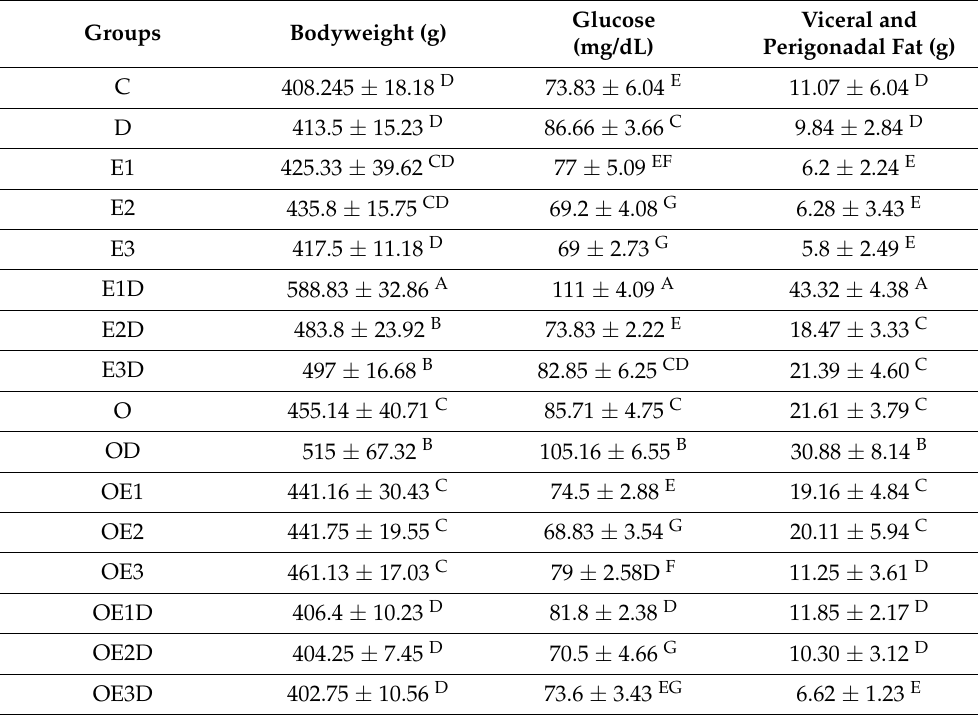
Table 3. Body weight and visceral and perigonadal fat, plasma glucose levels. Groups Bodyweight